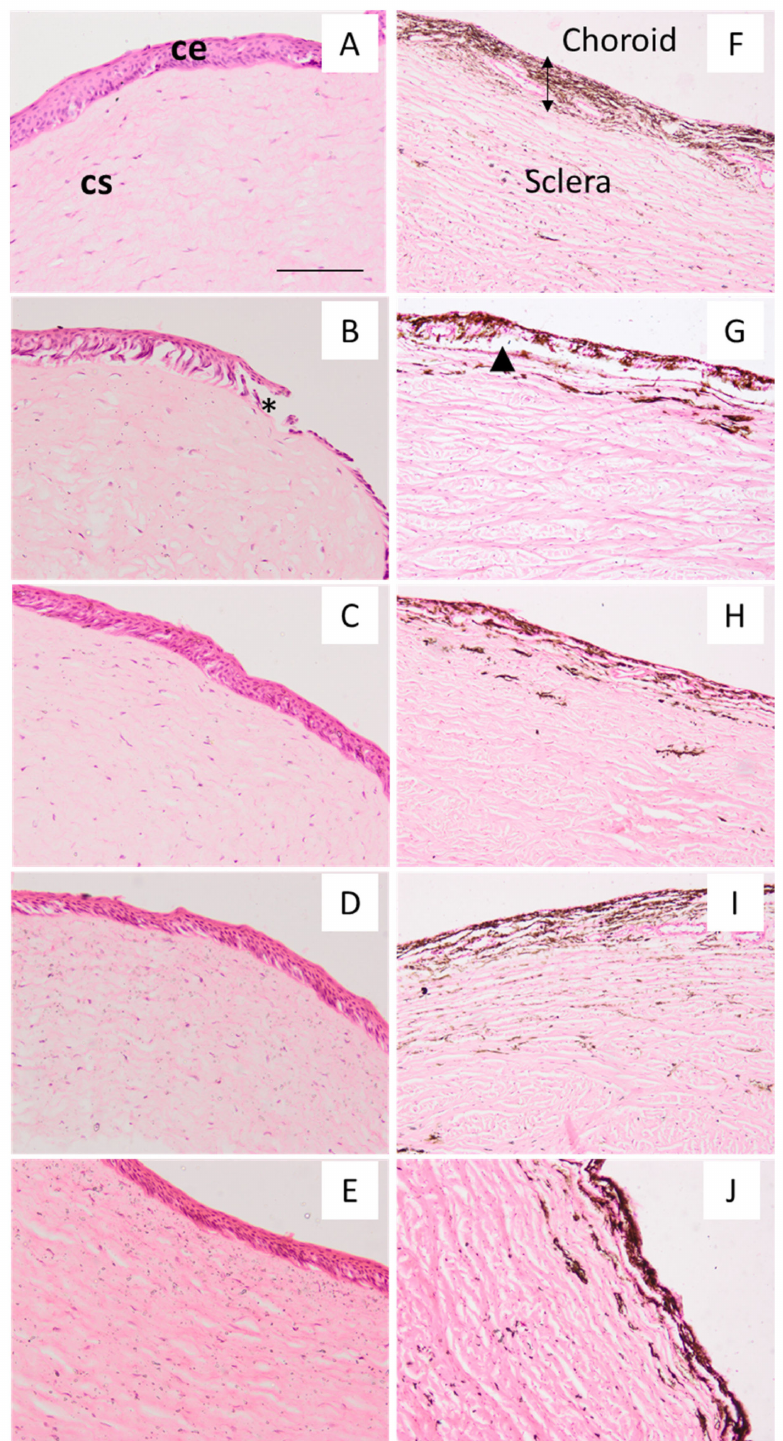
Figure 8. Cornea and sclera sections observed under the microscope. For histological assessment, sections of the cornea ( A – E ) and sclera ( F – J ) were stained with hematoxylin and eosin and pho- tographed at 200 × and 100 × , respectively. After the ex vivo permeation assay, tissues were treated with physiological serum ( A , F ), ethanol-water 50:50 ( B , G ), CSP-O1 ( C , H ), CSP-O2 ( D , I ), and CSP-O3 ( E , J ). ce—corneal epithelium; cs—corneal stroma (lamina propria). Asterisk indicates a loss of the corneal epithelium, and the arrowhead indicates a disruption of the choroid. Scale bar: 200 µ m (100 × ) and 100 µ m (200 ×